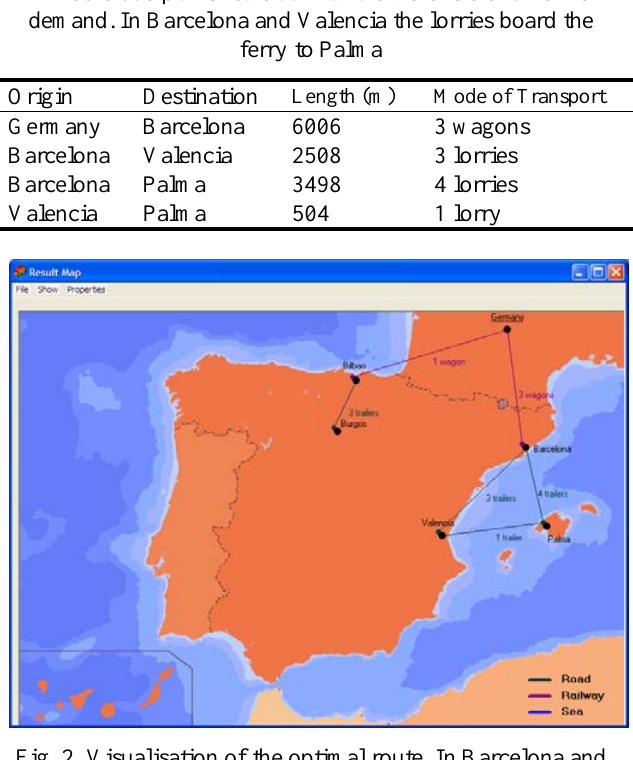
Table 6. Optimal solution for the Valencia and Palma demand. In Barcelona and Valencia the lorries board the